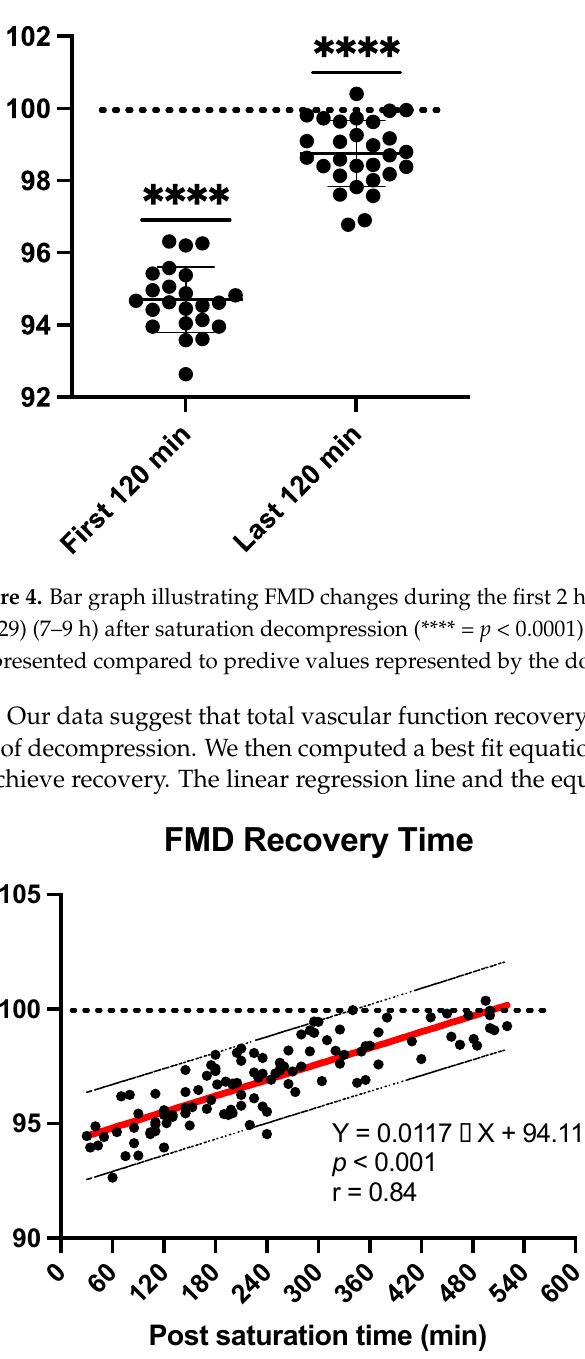
Figure 5. FMD evolution after exiting saturation the linear solution has been selected as the best fit approach, and the dotted lateral bands represent the 95% prediction bands.